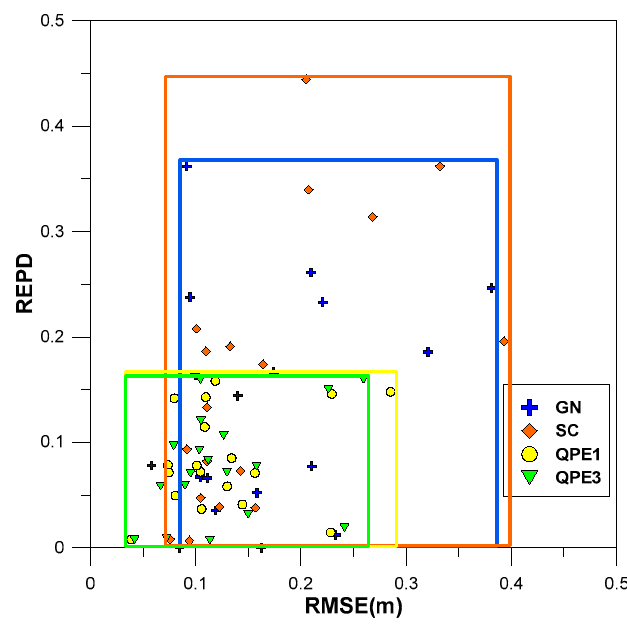
Figure 8. Evaluation results in terms of relative error of peak depth (REPD) and root mean square error (RMSE) for simulated depth using various QPE products. Table 3. Evaluation results in terms of REPD and RMSE for simulated water depth using various QPE products.